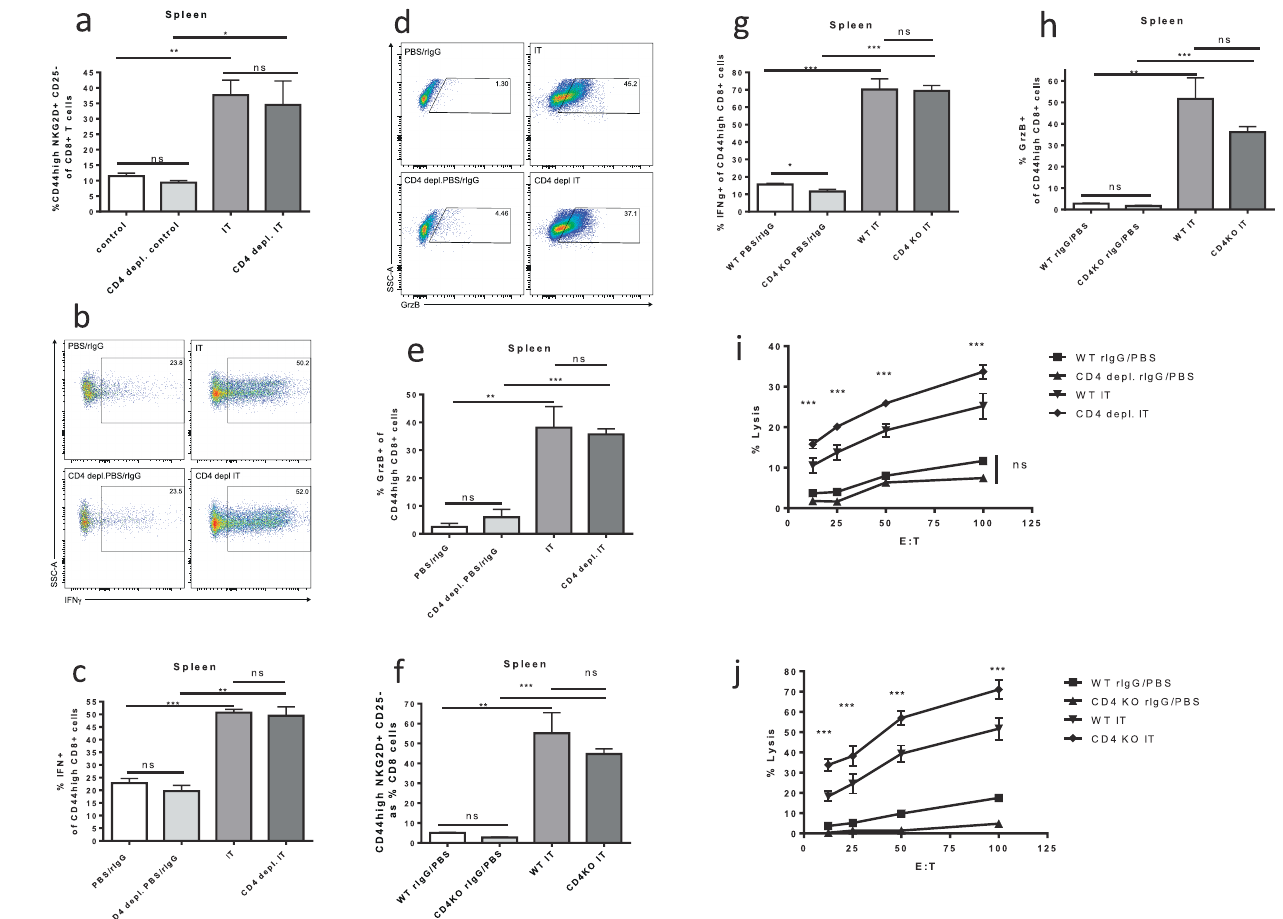
Figure 4. Memory CD8 + T cell function after IT in CD4 + T cell deficient models. Control or CD4 deficient (depleted or knockout) C57BL/6 mice were treated with IT or PBS/rIgG (control) and assessed for function of memory CD8 + T cells 11 days after the initiation of IT. NKG2D and granzyme B expression were quantified by flow cytometric analysis. Interferon gamma production was quantified by flow cytometric analysis after in vitro restimulation of splenocytes with PMA/Ionomycin (0.16/1.6 ug/ml) for one hour followed by incubation with golgi stop (0.7 ug/ml) for three hours. CD8 + T cell killing function was assayed by scintillation counting using an in vitro redirected lysis assay with 51 Cr labeled P815 target cells incubated for 30 minutes with 10 ug/mL anti-CD3e. ( a,f ) NKG2D expression on memory CD8 + T cells in CD4 depletion ( a ) and knockout ( f ) models. Representative dot plots for NKG2D + CD25 2 gating are presented in Figure 1. ( b ) Representative dot plots for IFN c + gating on CD8 + CD44 high cells in the spleens of CD4 + depletion model mice. ( c,g ) Interferon gamma production by memory CD8 + T cells in CD4 depletion ( c ) and knockout ( g ) models. ( d ) Representative dot plots for Granzyme B + gating on CD8 + CD44 high cells in the spleens of CD4 + depletion model mice. ( e,h ) Granzyme B expression by memory CD8 + T cells in CD4 depletion ( e ) and knockout ( h ) models. Killing function of splenocytes from CD4 depleted ( i ) or CD knockout ( j ) mice expressed as percentage of maximal lysis. Results are representative of two (CD4 knockout) or three (CD4 depletion) independent experiments with a minimum of three mice per group. (* P , .05, ** P , .01, *** P ,